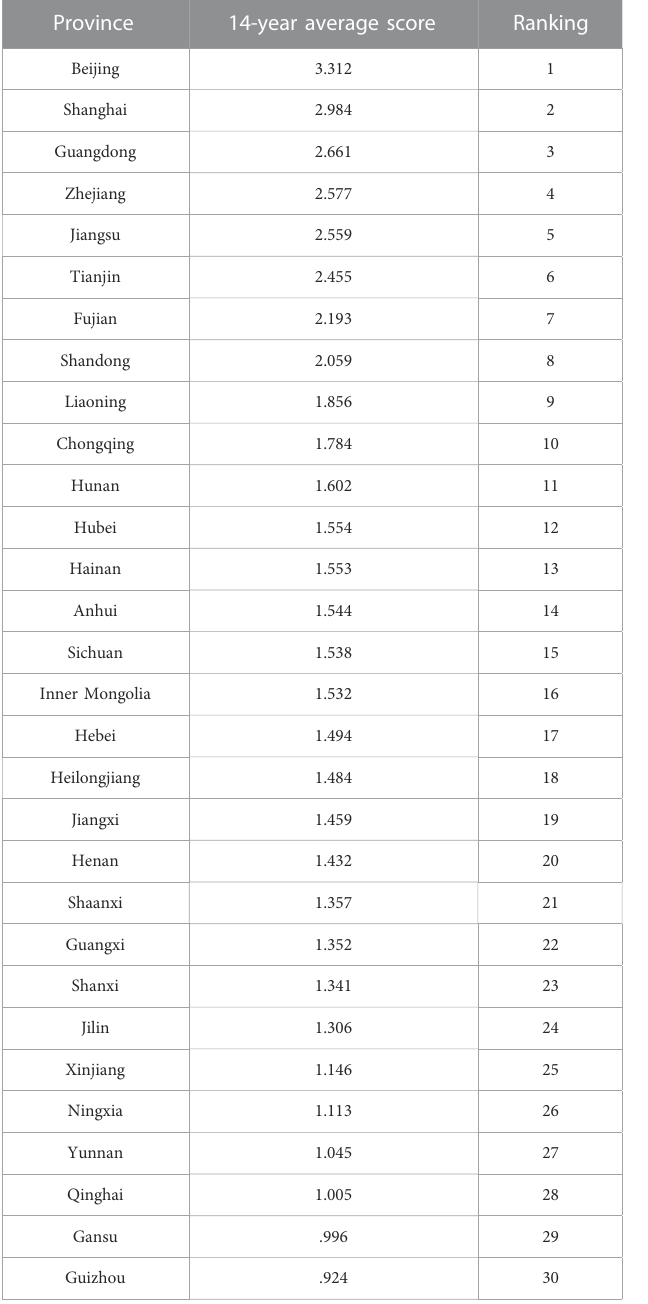
TABLE 4 Ranking of the DB environment from 2007 to 2020.